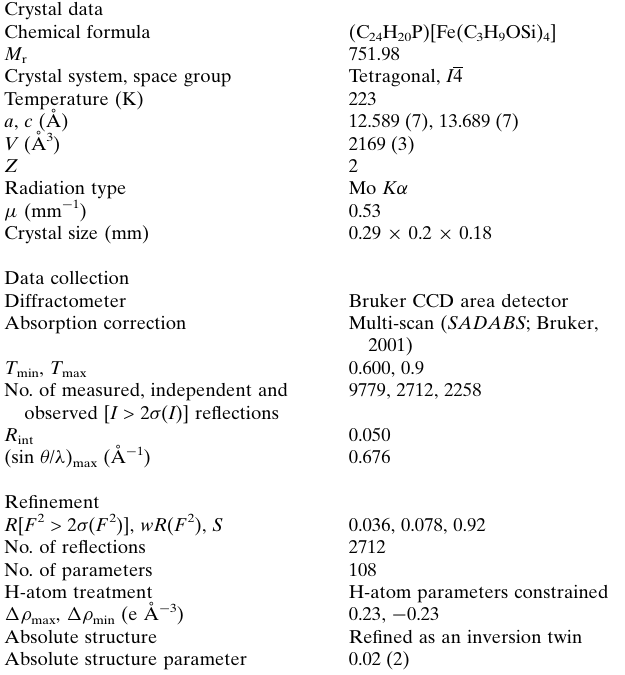
Table 1 Hydrogen-bond geometry (A˚ , (cid:2) ).